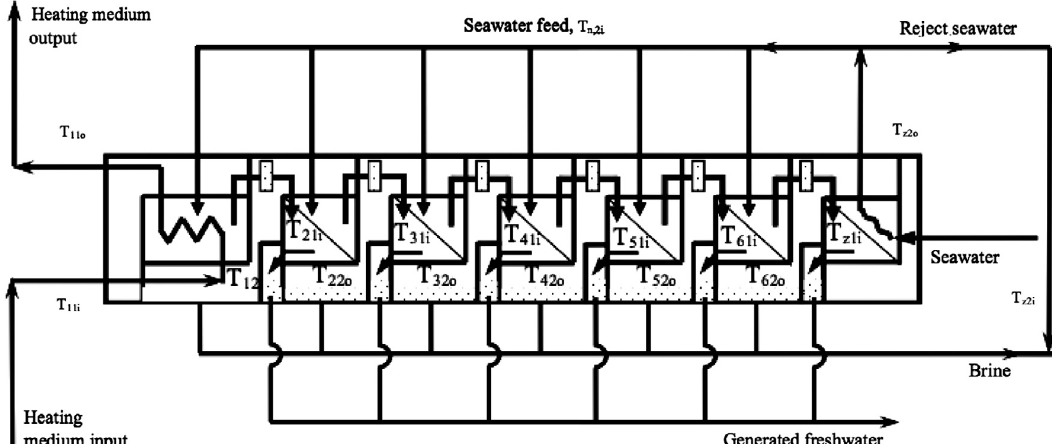
Figure 1. Schematic of a basic multi-effect-distillation system